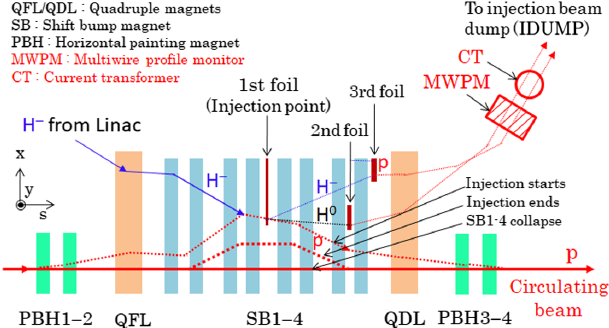
FIG. 3. Simulated circulating p distributions on the first foil at the end of injection for the MLF (black) and MR (red) beam parameters. Because of a smaller TP area for the MR, the sweeping rate of circulating p is slower, which results in an order of magnitude higher average foil traversal of each injected p as compared that of MLF with a bigger TP area.